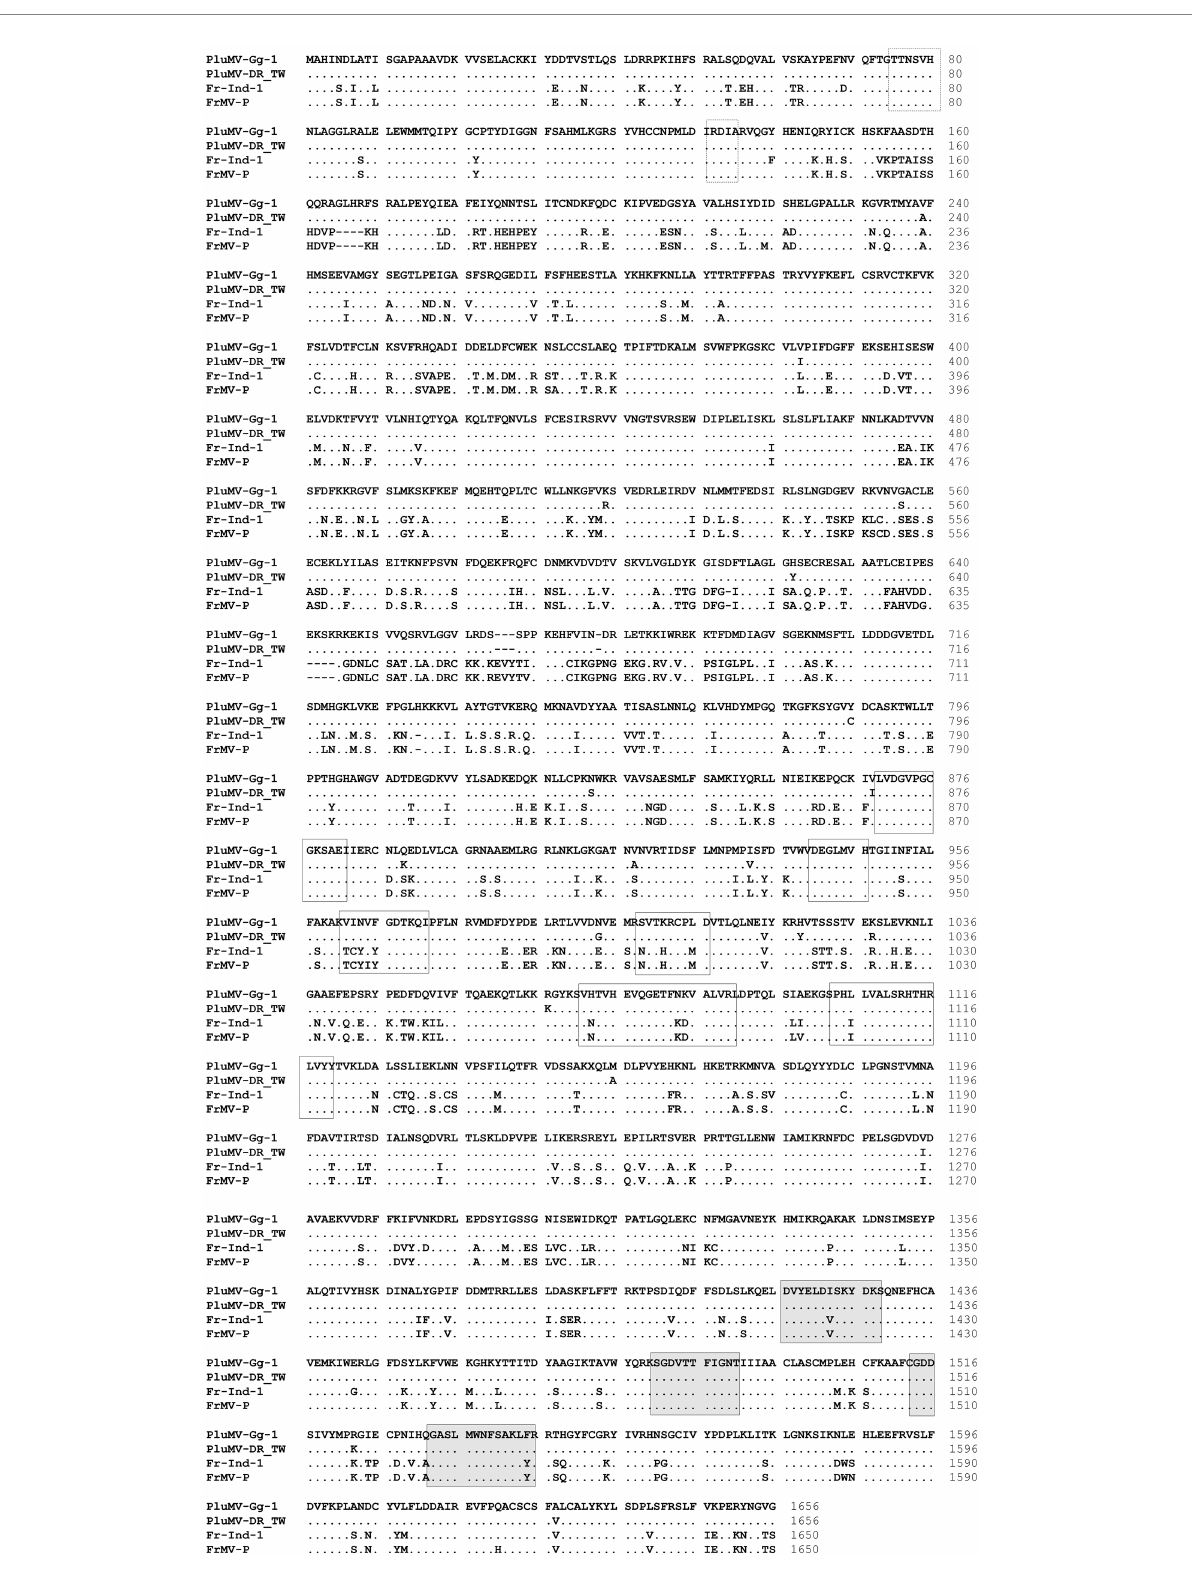
FIGURE 4 Comparison of the amino acid sequence of the large replicase protein of two isolates of plumeria mosaic virus (PluMV-Plu-Ind-1 and PluMV-DR_ TW) with that of the isolates of closely related frangipani mosaic virus (FrMV-Ind-1 and FrMV-P). Boxes with dotted line showing conserved motifs of methyltransferase domain, boxes with continuous line showing motifs for helicase domain, and shaded boxes showing motifs for polymerase domain. Dot indicates identical amino acid, dash indicates